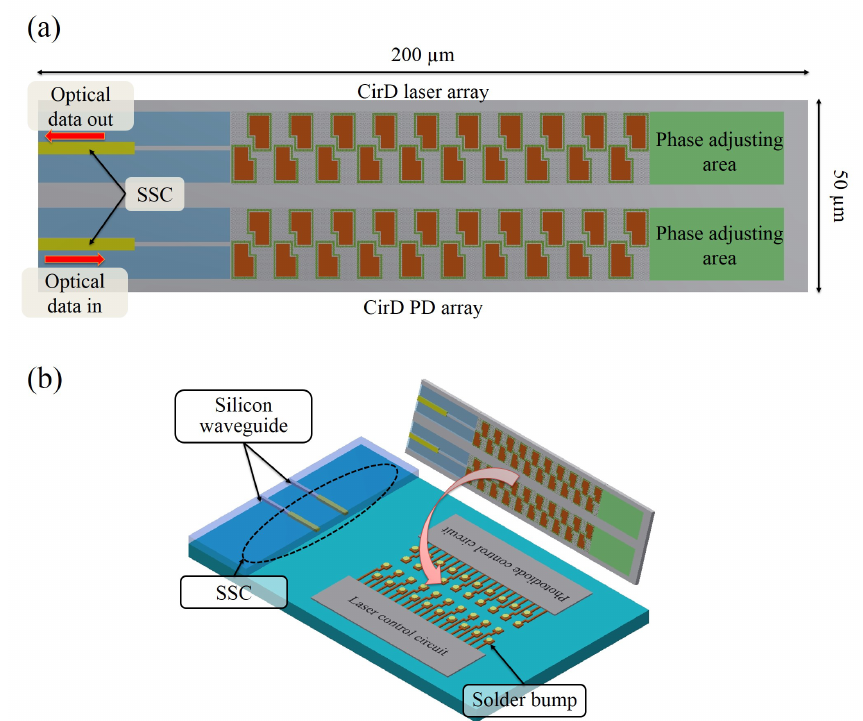
Figure 4. ( a ) Schematic of monolithic integrated optical module combined with wavelength division multiplexing and demultiplexing functions. ( b ) Schematic of flip-chip boding of integrated optical module to silicon